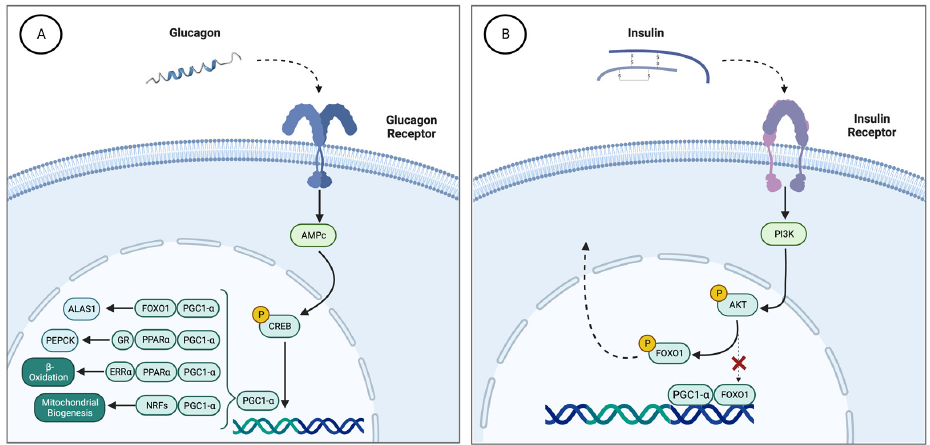
Figure 1 . ( A ) Effect of glucagon on hepatic ALAS1 through PGC1a. During fasting periods, there is an increase in serum glucagon. This hormone stimulates the cAMP and CREB pathways, which activate the expression of the PGC-1 gene. Then, PGC-1 α recruits different transcription factor binding promoters such as PEPCK (PGC1 α , GR and PPAR α ) to induce gluconeogenesis, GP (FOXO, HNF4 α and PGC1 α ) to enhance glycogenolysis, induces the expression of NRFs that increase mitochondrial DNA transcription and replication, and stimulates the heme biosynthetic pathway through the activation of ALAS1 (FOXO1 and PGC1 α ). ( B ) Effect of insulin on PGC1 α . Carbohydrate intake produces an increase in serum insulin levels, with the consequent activation of the PI3K pathway. PI3K regulates the phosphorylation of AKT, which in turn phosphorylates FOXO1. Phosphorylation of FOXO1 disrupts the transcriptional complex it forms with PGC1 α , such that FOXO1p